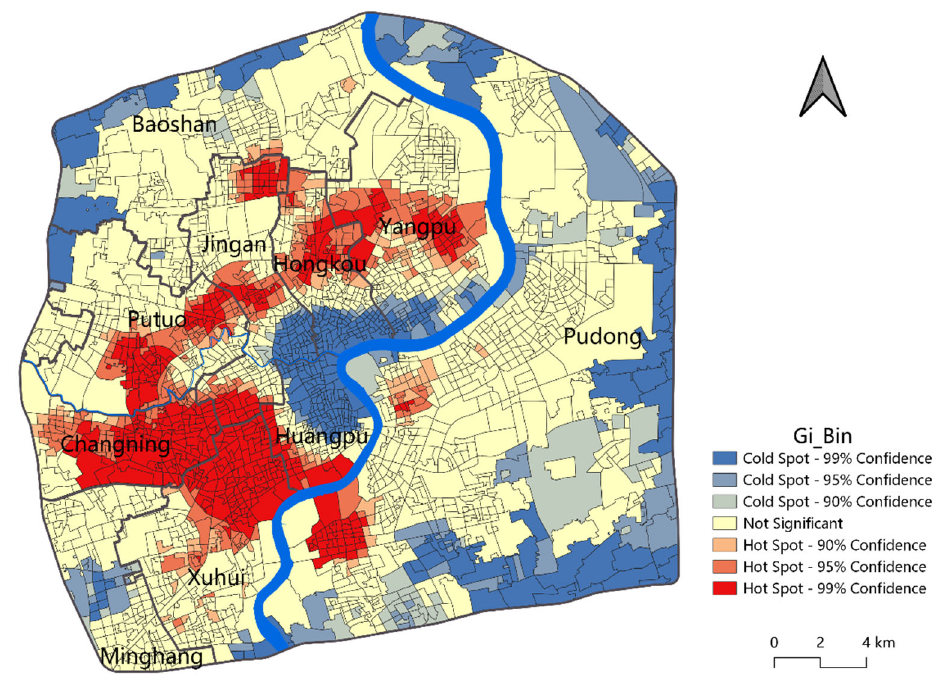
Figure 10. The hot/cold spots of flood vulnerability in central urban areas.